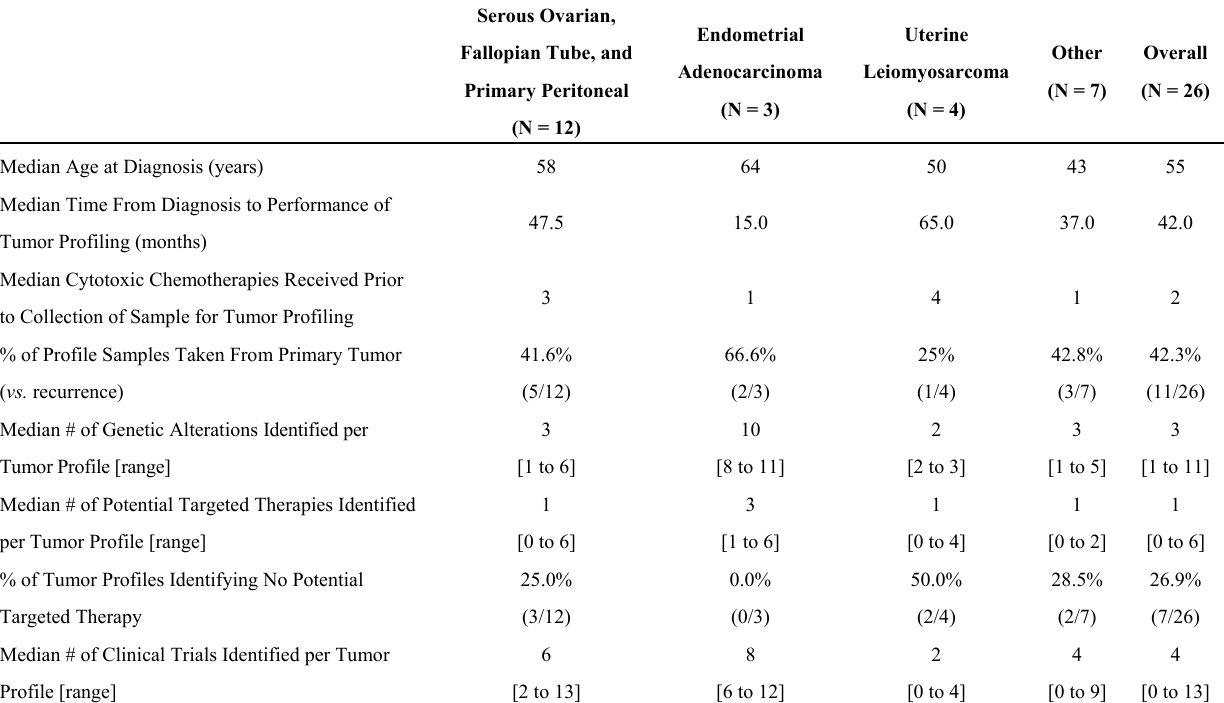
Table 1. Summary of molecular profiling results by tumor type. The primary results of molecular profiling performed on samples from the 26 patients in this series are summarized in this